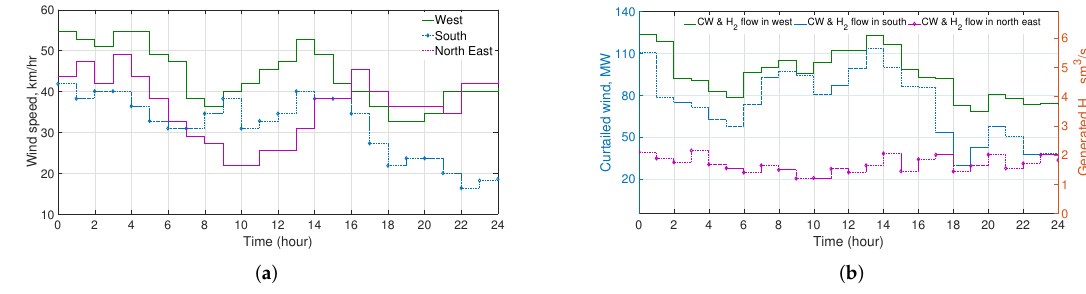
Figure 3. Comparison between( a ) Wind speed profile in three different regions of Ireland and ( b ) Variable CW and H 2 generated in three different regions of Ireland on 11 October 2017.